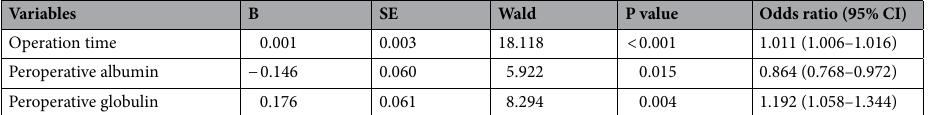
Table 4. Multivariate logistic regression analysis of risk factors influencing postoperative hypoalbuminemia in the patients underwent craniotomy for brain tumor. Adjusted for body mass index, intraoperative blood